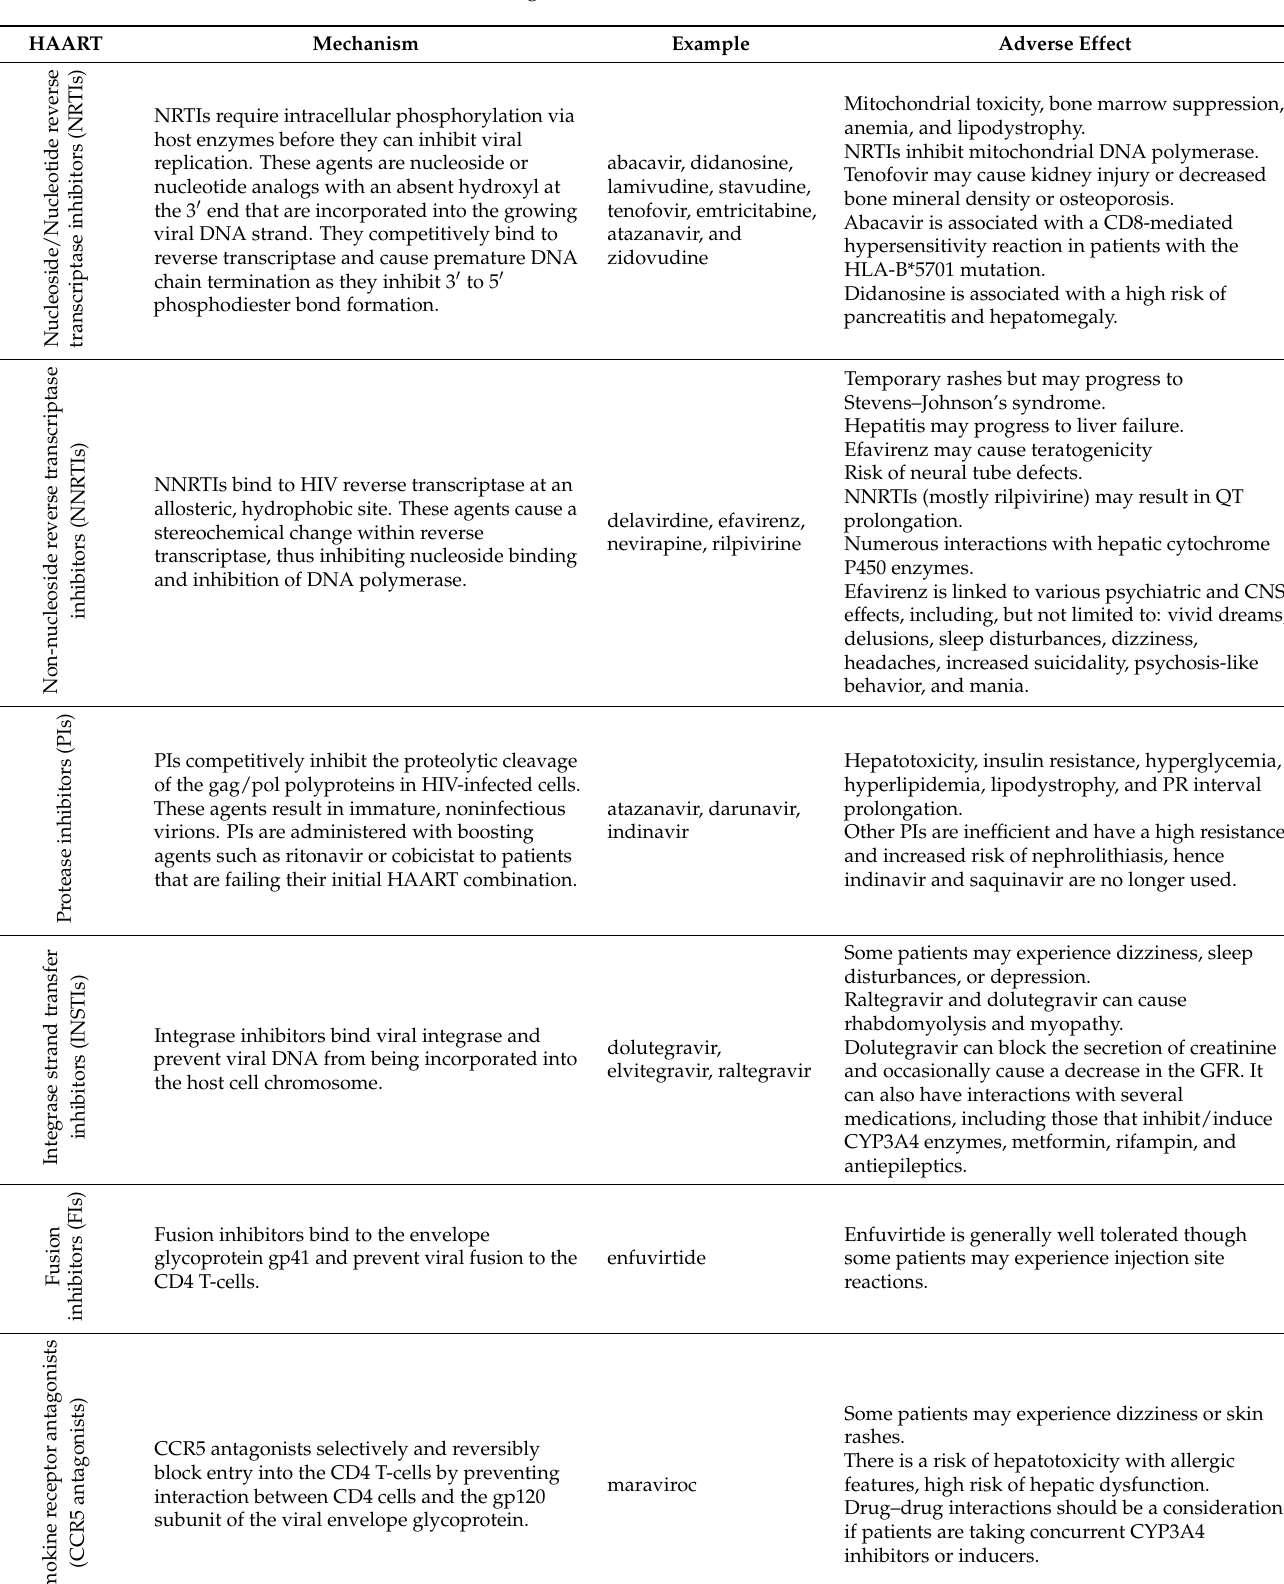
Table 1. HAART drugs mechanism and their adverse